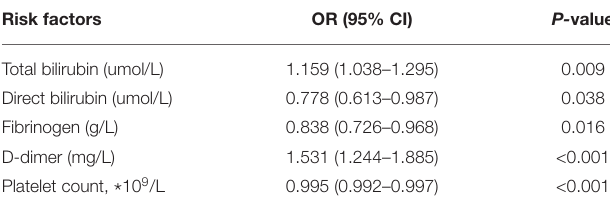
TABLE 4 | Risk factors in AAA group and PAD